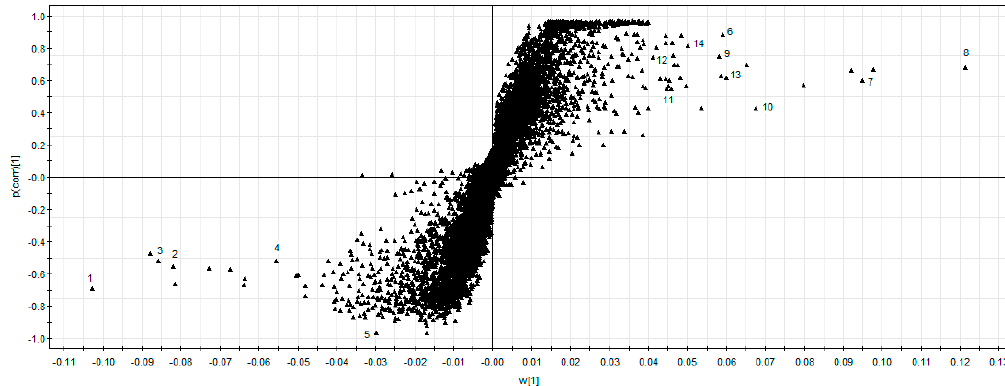
Figure 4. The S-Plot of LX-P and LX-L. 1 ion (t R 4.56 min, m / z 1109.6176), 2 ion (t R 4.76 min, m / z 1079.6058), 3 ion (t R 4.98 min, m / z 1079.6069), 4 ion (t R 5.56 min, m / z 947.5623) and 5 ion (t R 10.00 min,